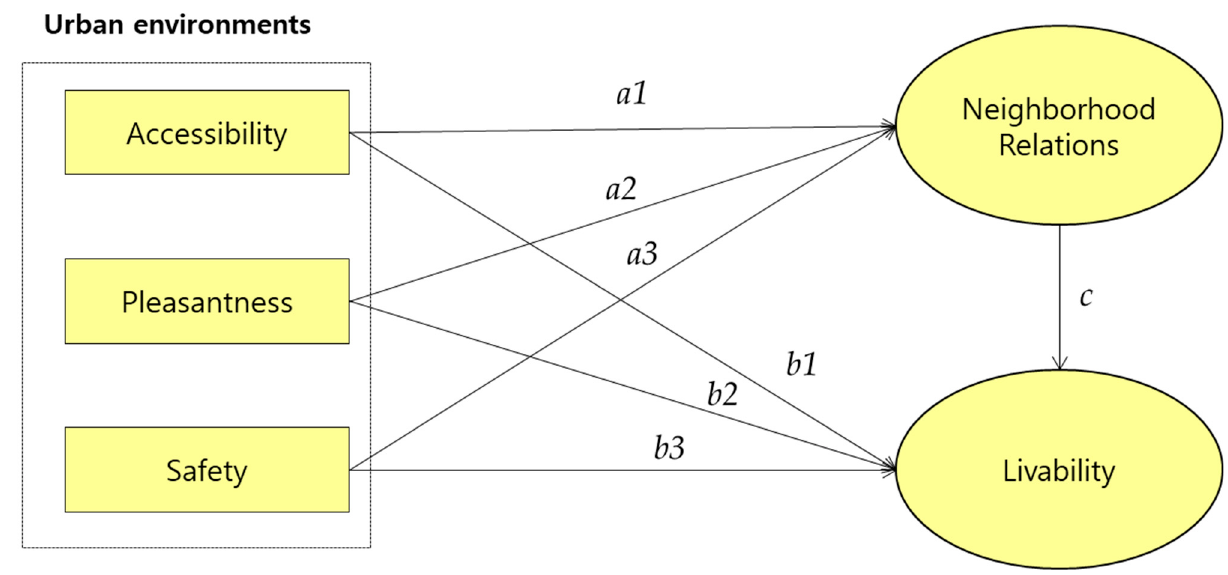
Figure 2. Research model.